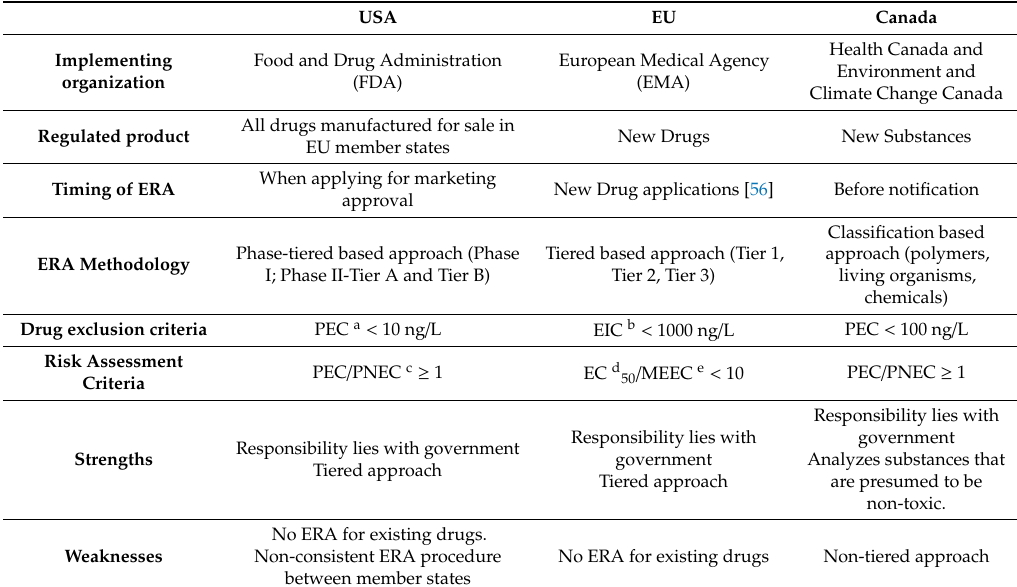
Table 2. Characteristics of Environmental Risk Assessment (ERA) regulatory approach implemented in USA, EU, and